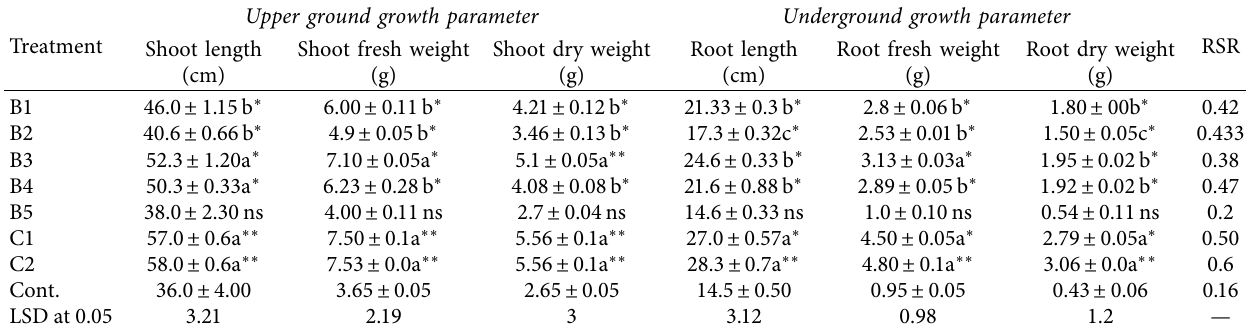
Table 4: The effect of Bacillus and cyanobacteria isolates on the growth of Rice Cv. X-jegna seedlings.